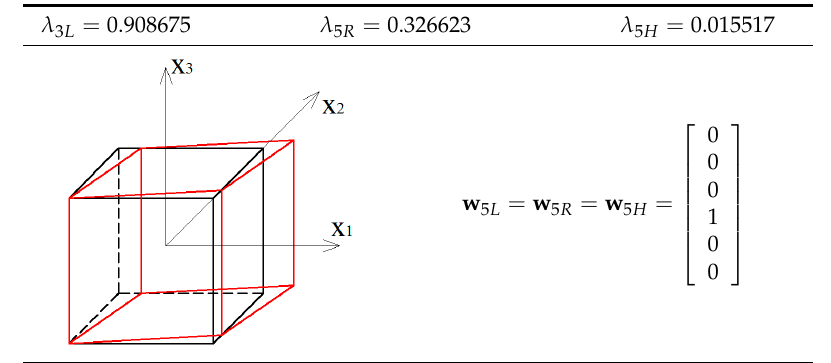
Table 5. Low shear mode of deformation.